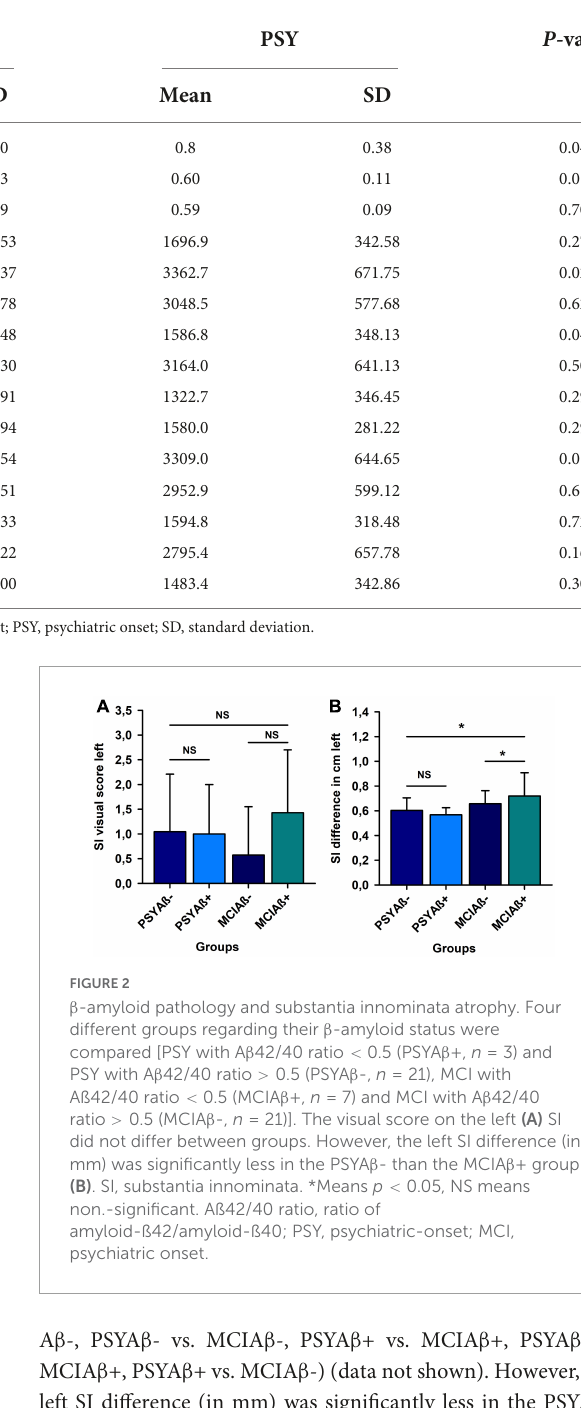
TABLE 2 Short overview of volumetric analysis.